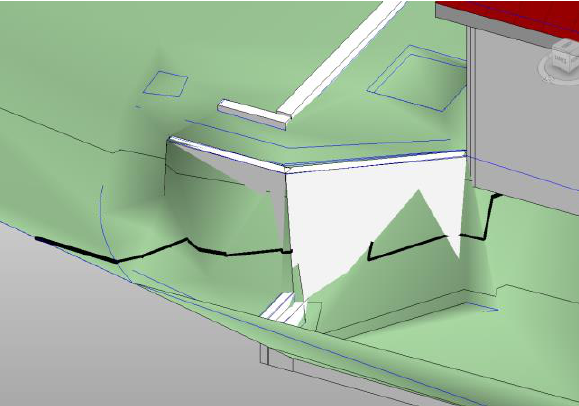
Figure 3 Terrain cuts elements and obstruct the